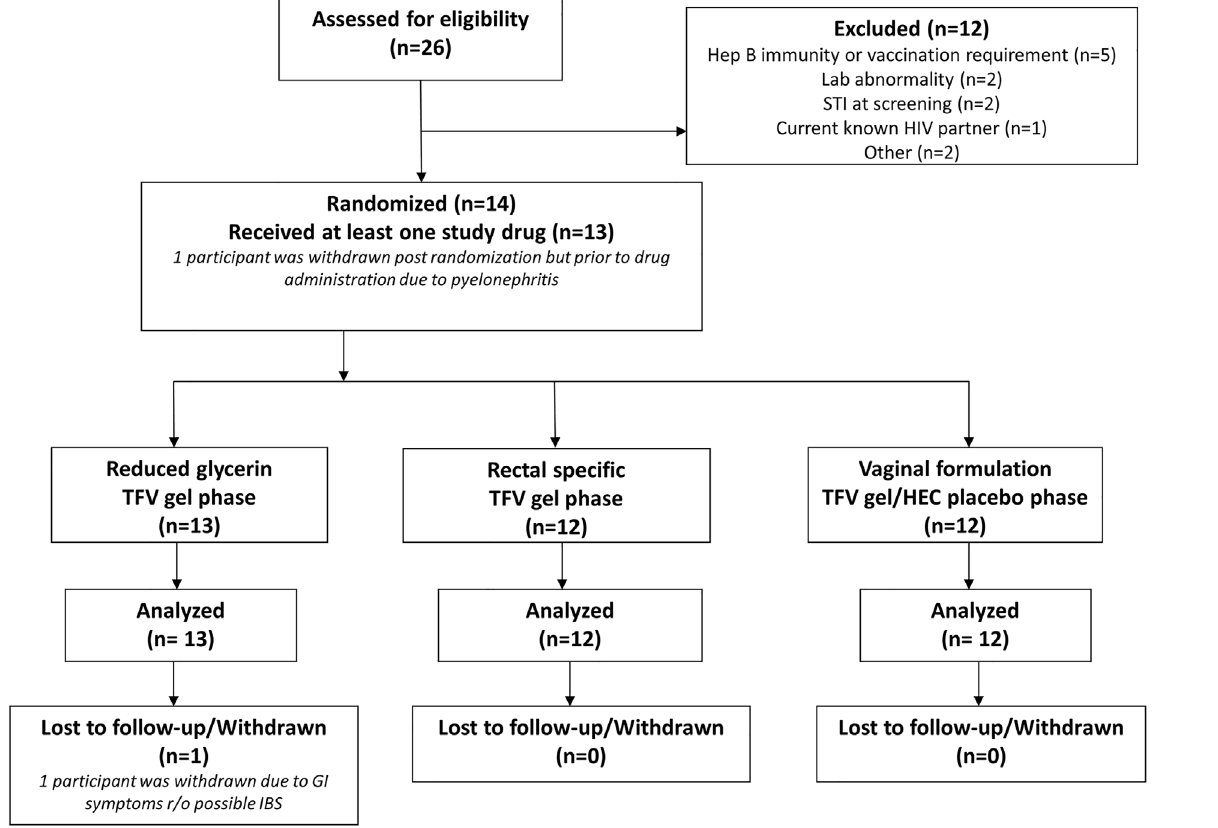
Fig 2. Flow diagram of participant progress through the CHARM-01 study.